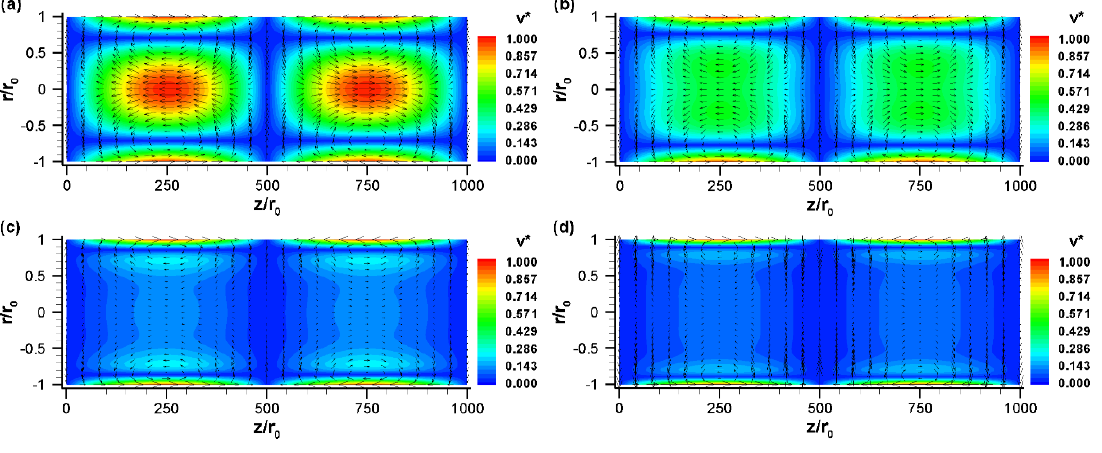
(cid:12) (cid:12) → (cid:12) (cid:12) v V u  (cid:12) (cid:12) V / u HS (contour HS (cid:12) (cid:12)